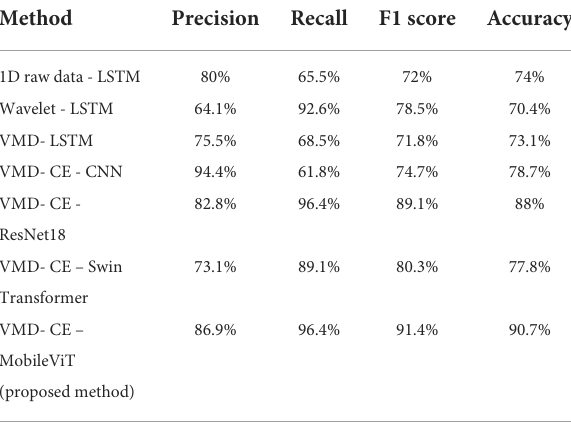
TABLE 3 The comparison of different methods for the detection of cottonseed with slight crack. Method Precision Recall F1 score